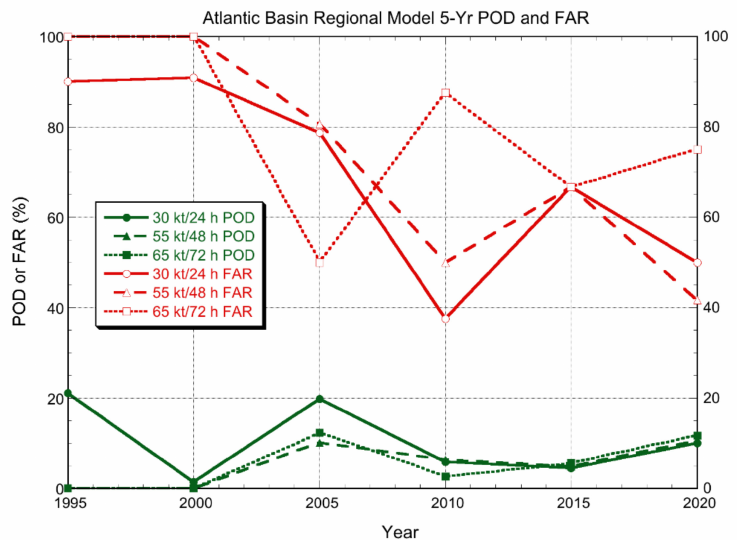
Figure 2. Atlantic basin POD (green) and FAR (red) for representative regional hurricane models for each of the three RI thresholds, 30 kt/24 h, 55 kt/48 h, and 65 kt/72 h. Each point on the diagram represents a five-year sample of forecasts ending at the year indicated. The regional models evaluated here were GFDL from 1992–1995, GFDI from 1996–2005, and HWFI from 2007–2020 (no GFDL forecasts were available in 1991 and no HWFI forecasts were available in